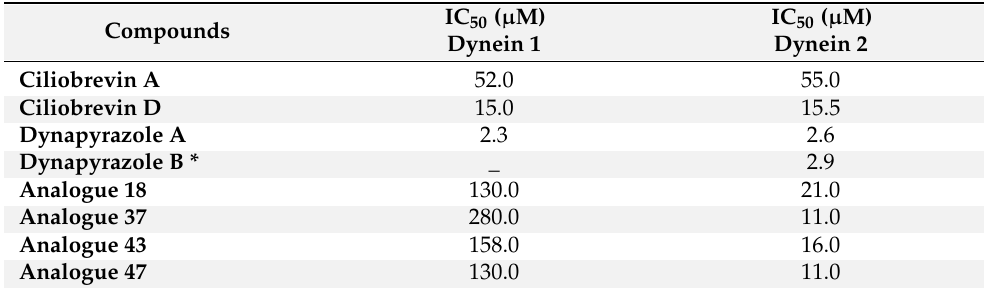
Table 4. IC 50 values of ciliobrevin A and D, their analogues 18, 37, 43, and 47, and dynapyrazole A and B for dynein 1 and dynein